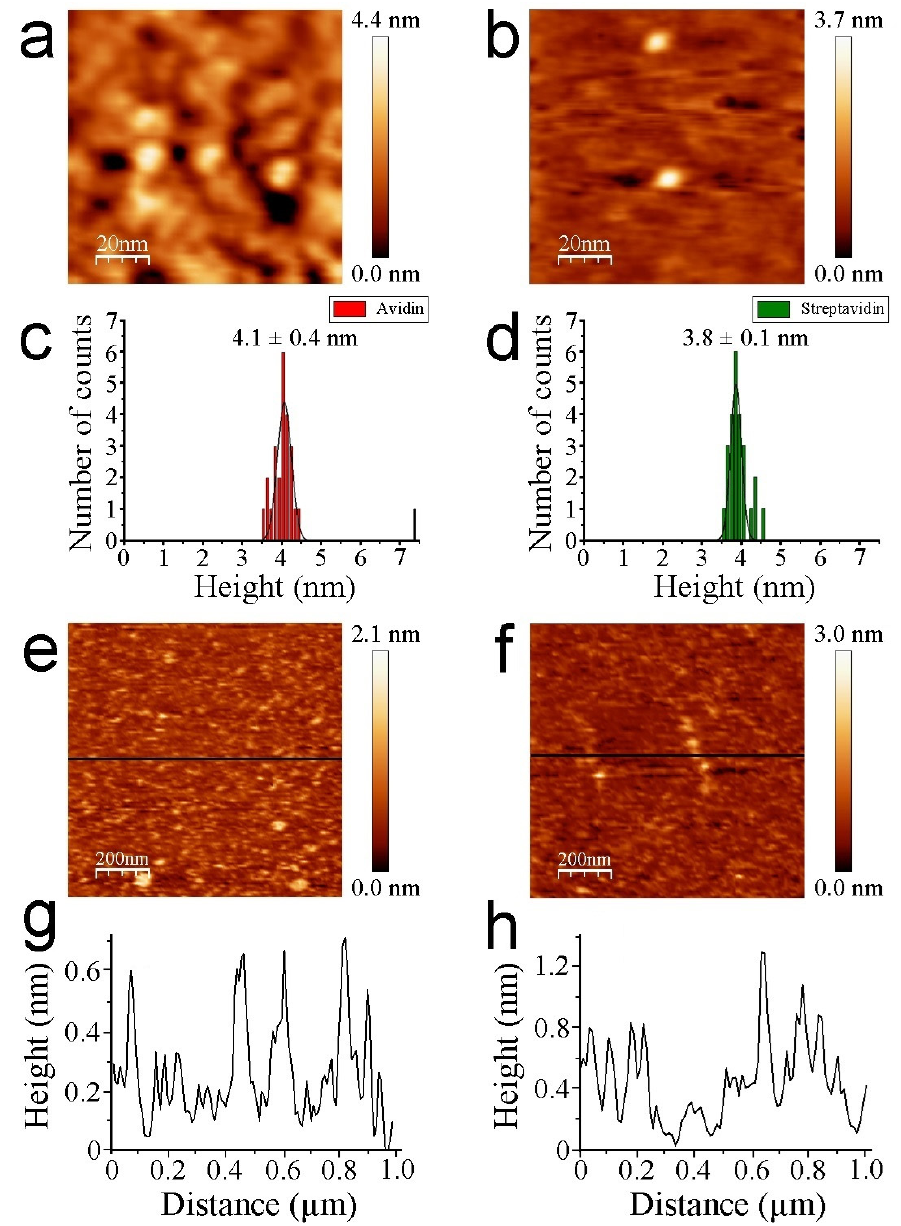
Figure 3. Representative AFM images of individual avidin ( a ) and streptavidin ( b ) protein molecules. Scan size is 100 nm × 100 nm. Histogram height analysis of avidin ( c ) and streptavidin molecules ( d ) (N 25). Topography of thiol monolayers ( e ) and a scratched area ( f ). Scan size is 1 µm × 1 µm. Cross-section profiles are depicted for aforementioned layers (( g ) and ( h ), respectively). Black lines represent the region where the cross-section profiles are traced.